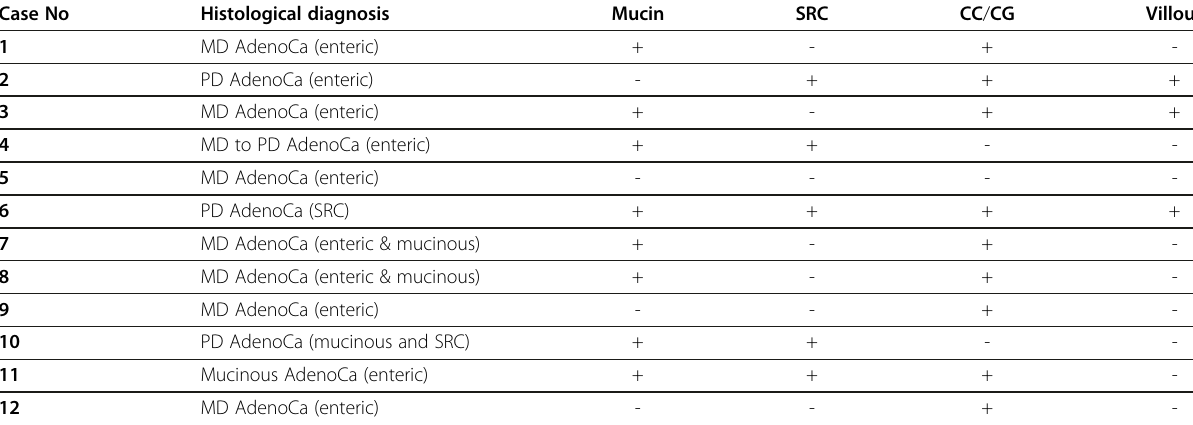
Table 3 Pathologic features of primary bladder adenocarcinoma Case No Histological